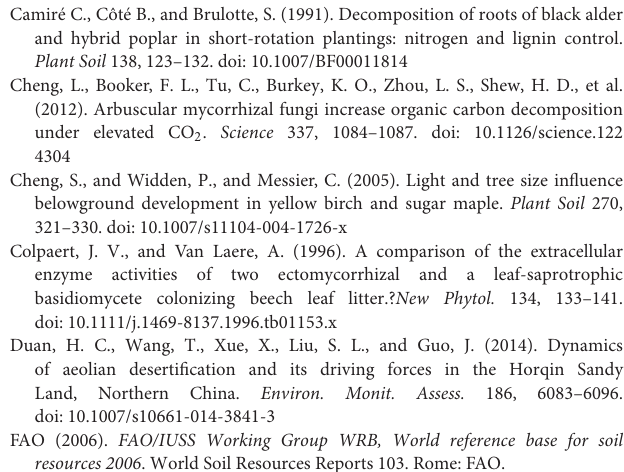
Supplementary Figure 1 | Vertical patterns of soil moisture content under litterbags after 1 year of decomposition of the fine roots of A. halodendron of the following three treatments: fine root and mycelia (R + M), mycelia (M) and bulk soil (S). Values represent M ± SD . Supplementary Figure 2 | Vertical patterns of soil C concentration under litterbags after 1 year of decomposition of the fine roots of A. halodendron . Values represent M ± SD . Bars labeled with different letters differed significantly among treatments ( P < 0.05). Soil C concentration decreased gradually with the increase of soil depth. This vertical pattern was significant for the bulk soil (S) and was weakened by the presence of fine root + mycelia (R + M) and of mycelia (M) under the A. halodendron canopy in Horqin sandy land, northeast